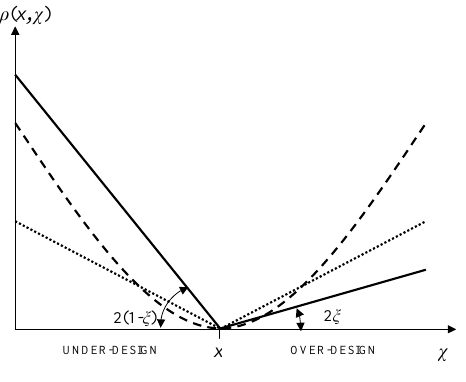
Fig. 1. Examples of quadratic (dashed line), absolute-value (dotted line) and asymmetric (continuous line, see Eq. 6) cost-loss func- tions. The variable χ on the horizontal axis is the “design” value, while x is the real future